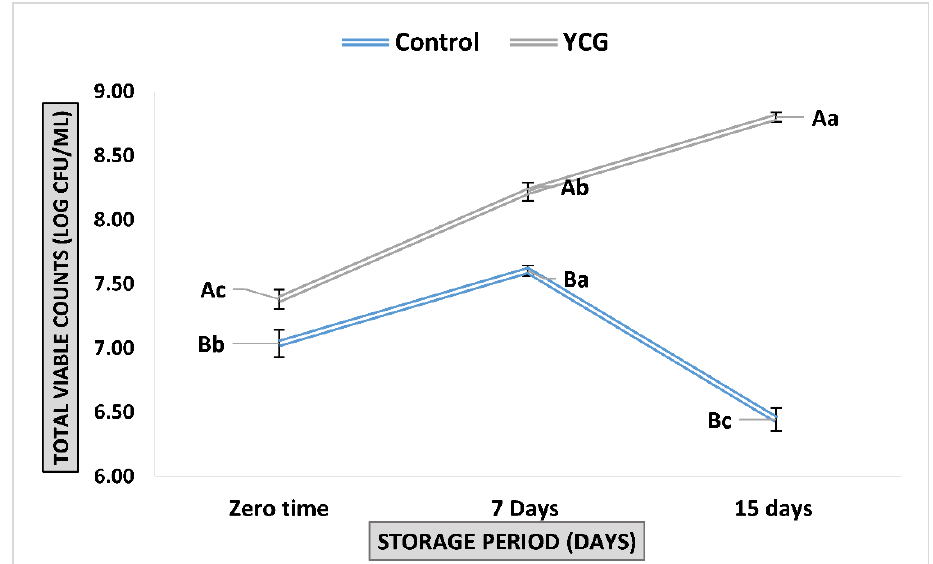
Figure 5. E.coli Nissle 1917 (EcN) counts (log CFU/mL) in YCG during the cold storage period. Different uppercase superscripts indicate significant ( p < 0.05) differences between the values for different treatments. Different lowercase superscripts indicate significant ( p < 0.05) differences between the values during the storage period. Error bars represent the standard division of means.